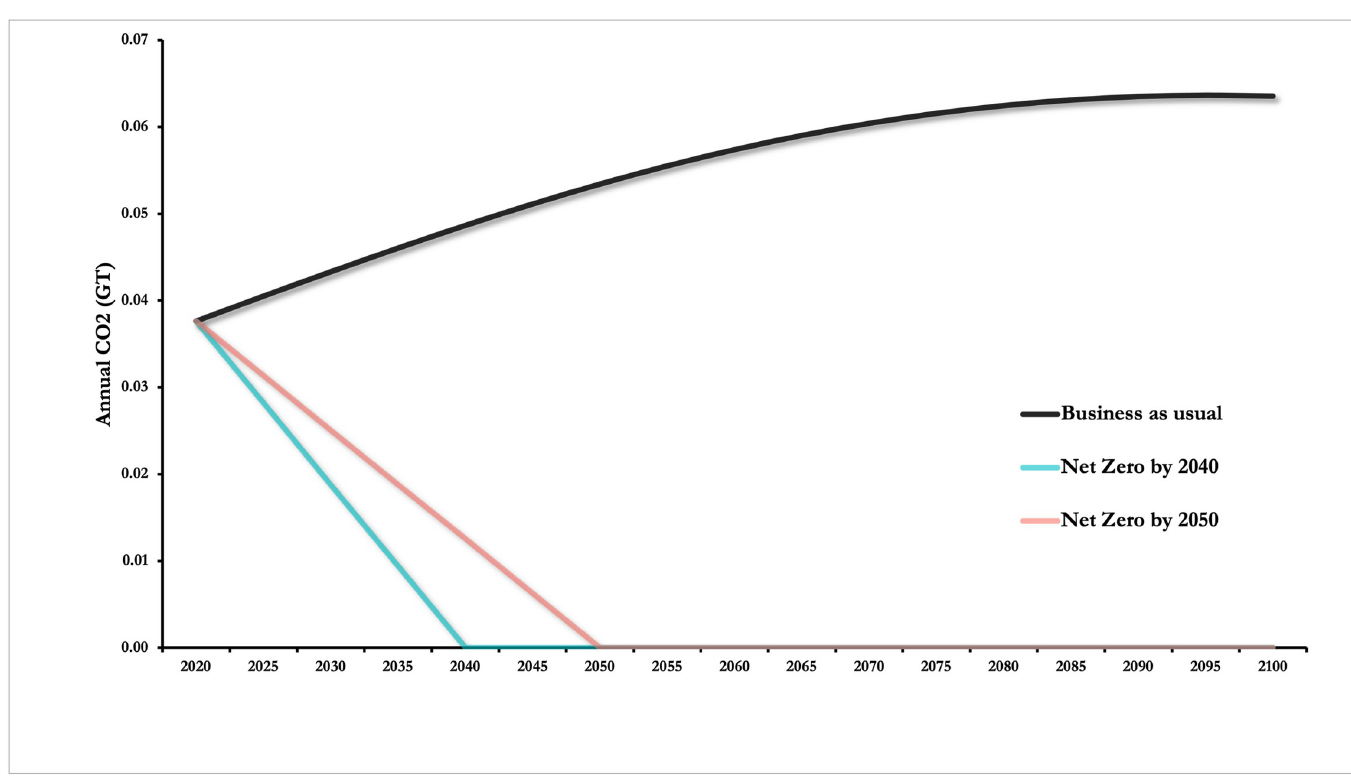
Fig 1. Australian health sector annual greenhouse gas emissions for hypothetical trajectories used in the model DICE-EMR to estimate the number of global deaths averted.